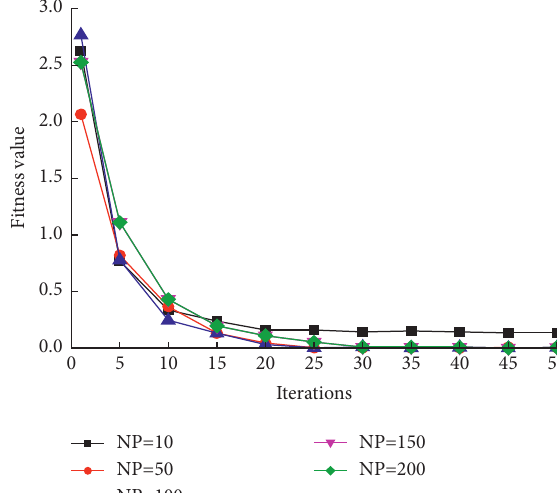
Figure 16: Iteration curve of different